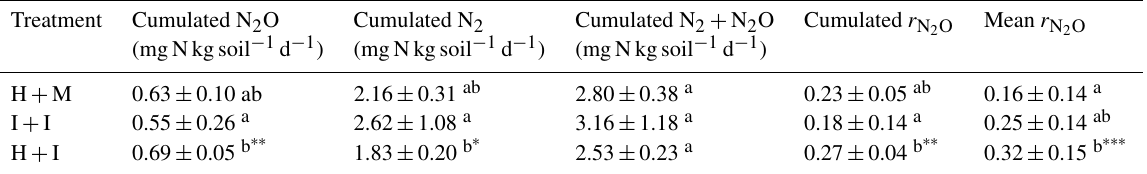
Table 1. Comparison of cumulated fluxes, cumulated product ratio (cumulated r N ments: homogenized and mixed (H + M), intact and injected (I + I), homogenized and injected (H + I). Statistically significant differences are indicated with superscript letters ( ∗ p< 0 . 05, ∗∗ p< 0 . 01, ∗∗∗ p< 0 . 001).